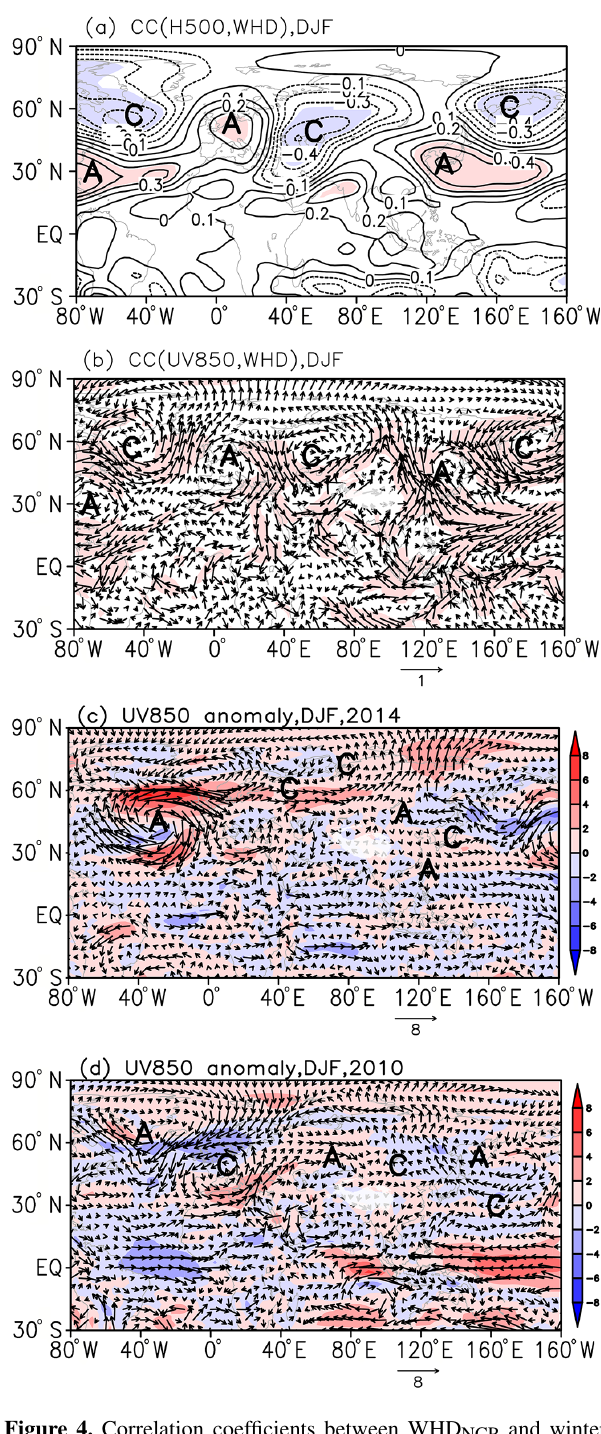
Figure 4. Correlation coefficients between WHD NCP and winter H 500 (a) / UV850 (b) from 1979 to 2012. The linear trend was removed, and shading indicates that the correlation coefficient ex- ceeds the 95% confidence level. UV850 (arrow) and speed (shad- ing) anomalies in winter 2014 (c) and 2010 (d) . Letters A and C represent anticyclone and cyclone,